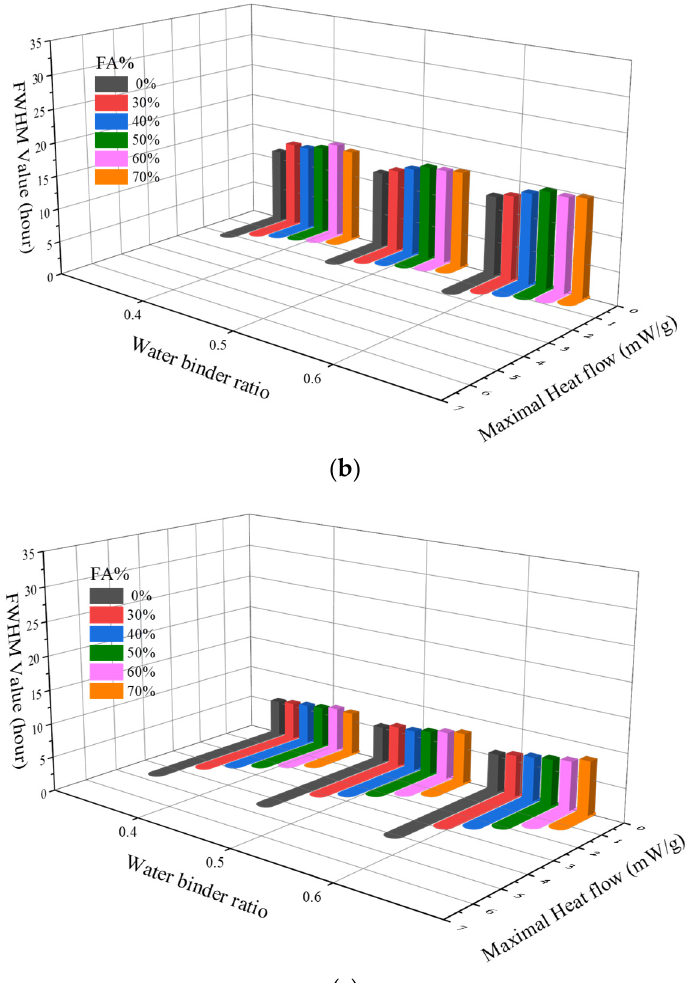
Figure 10. FWHM and exothermic peak values at different temperatures (normalized to paste). ( a ) FWHM and exothermic peak values at 10 °C; ( b ) FWHM and exothermic peak values at 20 °C; ( c ) FWHM and exothermic peak values at 35 °C.